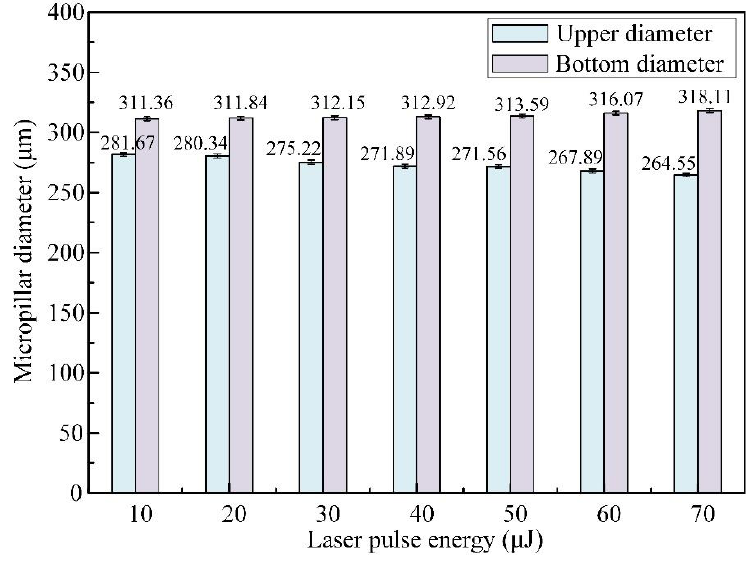
Figure 5. Effect of pulsed beam energies on the mean upper and bottom diameters of micropillars with a translation velocity of 1.0 m/s and a pulsed repetition rate of 600 kHz.